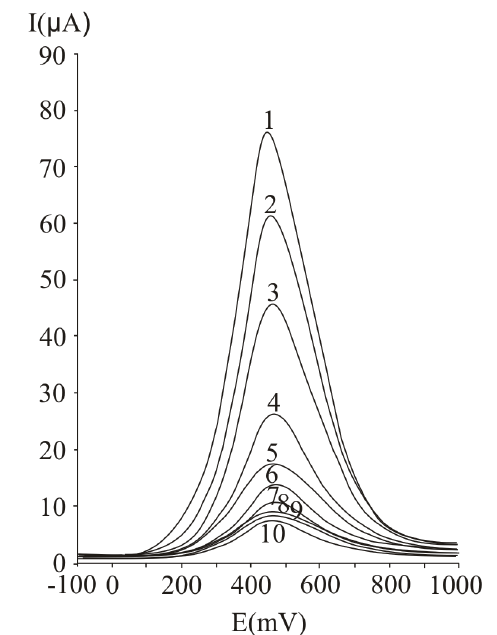
Figure 7. Differential pulse voltammograms obtained with a carbon paste working electrode for different ascorbic acid concentrations, expressed as mM: 20 (1), 15 (2), 10 (3), 5 (4), 2.5 (5), 1.25 (6), 0.625 (7), 0.31 (8) 0.15 (9) and 0.07 (10); experimental